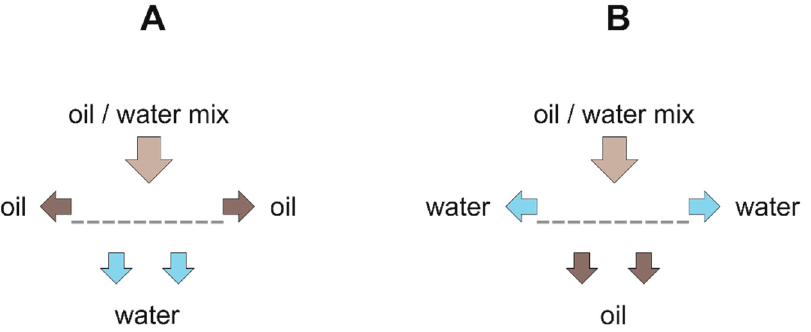
Figure 7. Separation mechanism of 2D materials: ( A ) hydrophilic/oleophobic filters; ( B ) hydropho- bic/oleophilic filters.